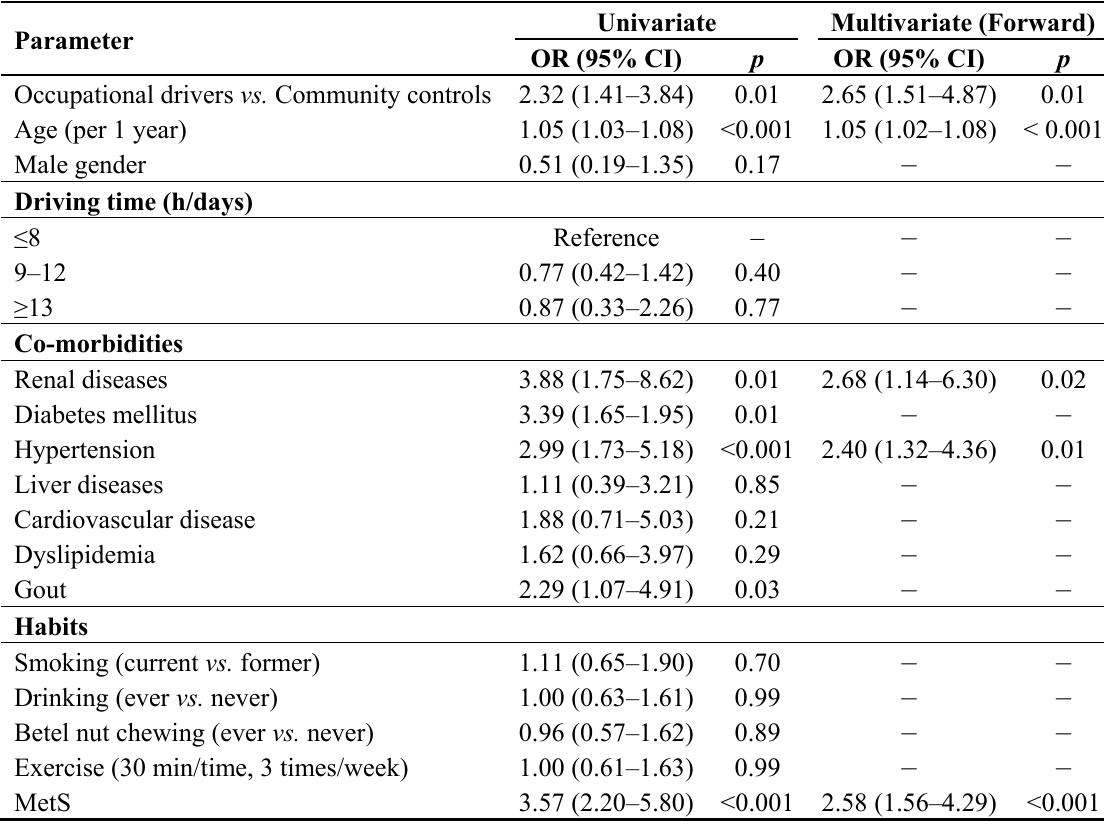
Table 3. Determinants of albuminuria in all